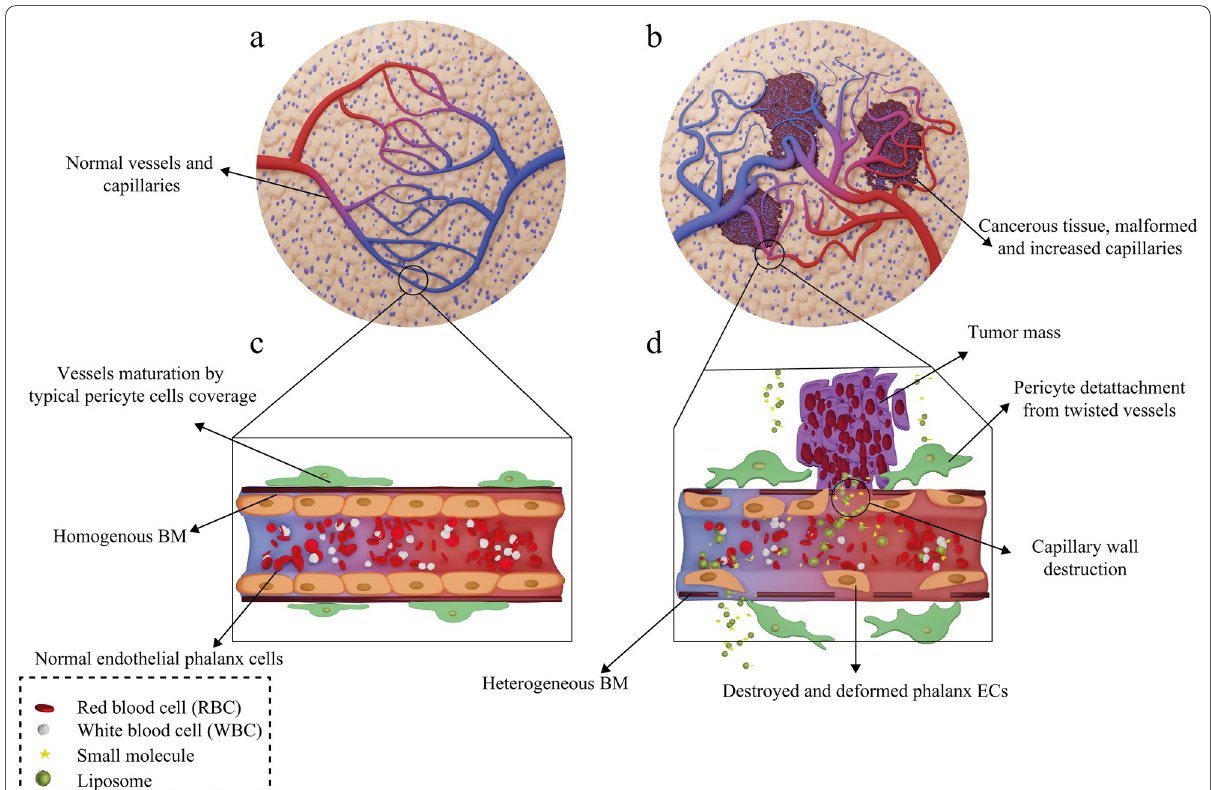
Fig. 7 Mechanism of action of the drug-containing liposomes on tumor cells via EPR effect. a Healthy tissue and its normal capillaries; b cancerous tissue with increased-deformed vessels; c structure of normal and healthy vessel; d destructions and deformed capillary in tumor